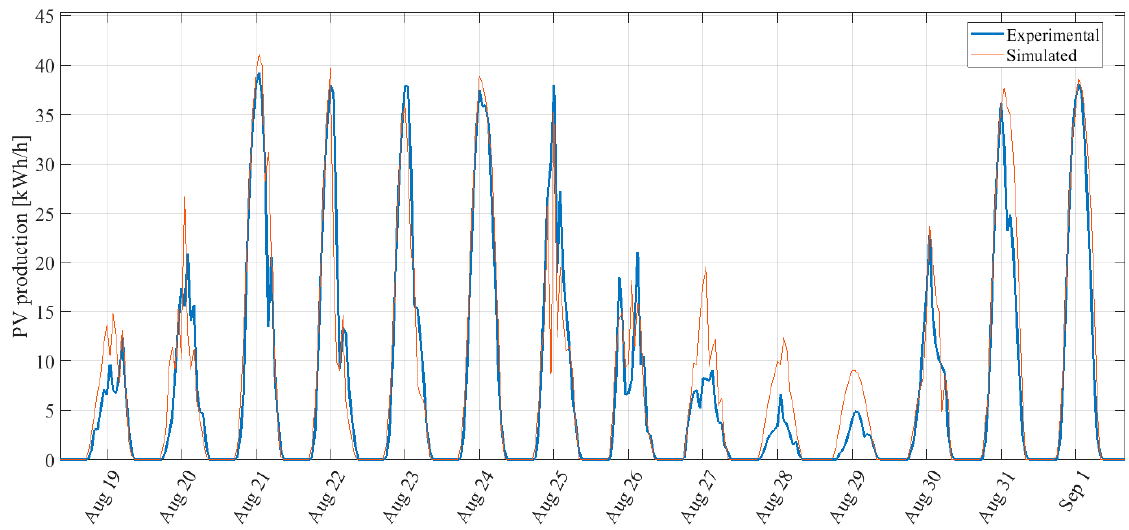
Figure 5. PV production during 14 days. On the horizontal axis, the ticks are placed at midday from August 19th to September